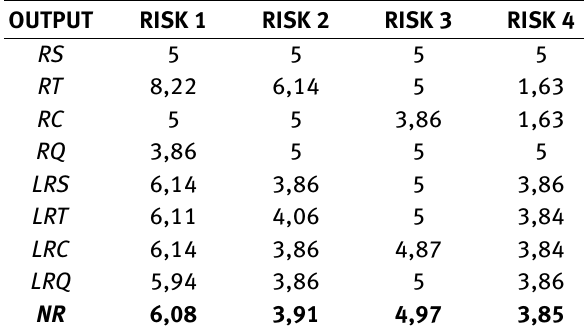
Table 7: Results of Piping Design Risk